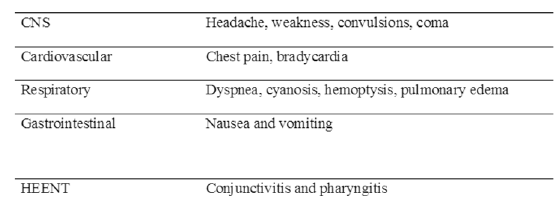
F‑067 Prognosis value of acute liver dysfunction after out‑of‑hospital cardiac arrest